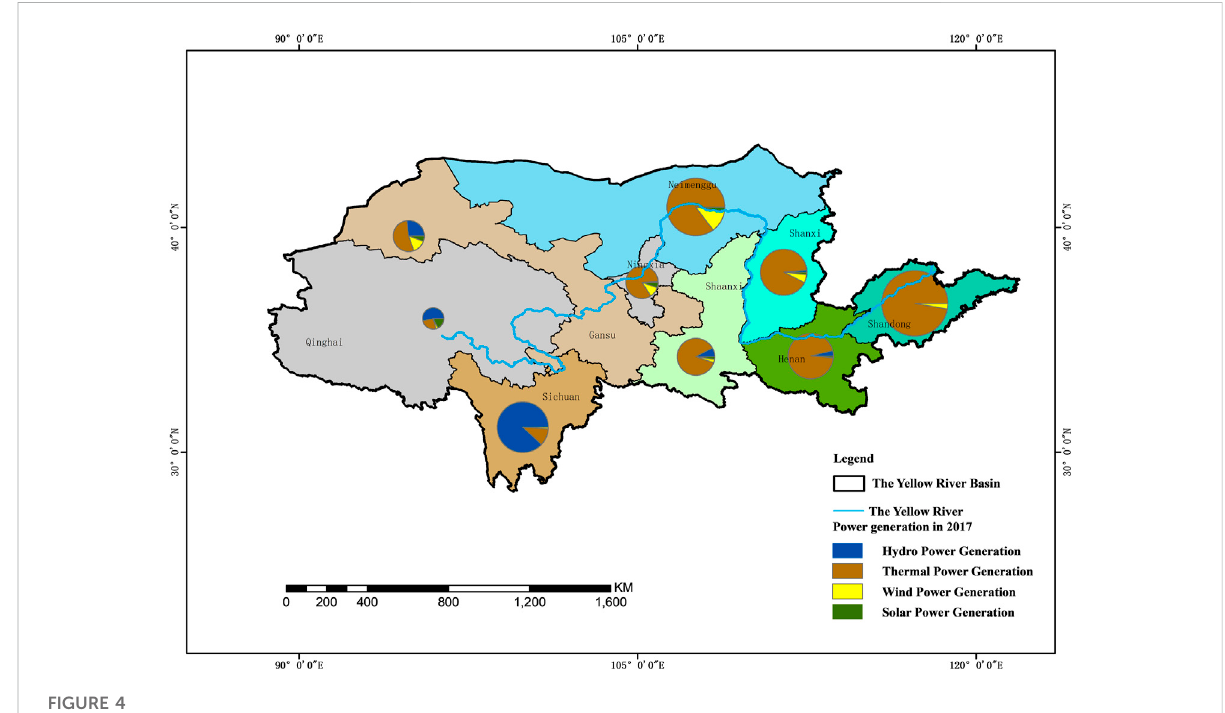
FIGURE 4 Energy structure of the Yellow River basin in 2017.